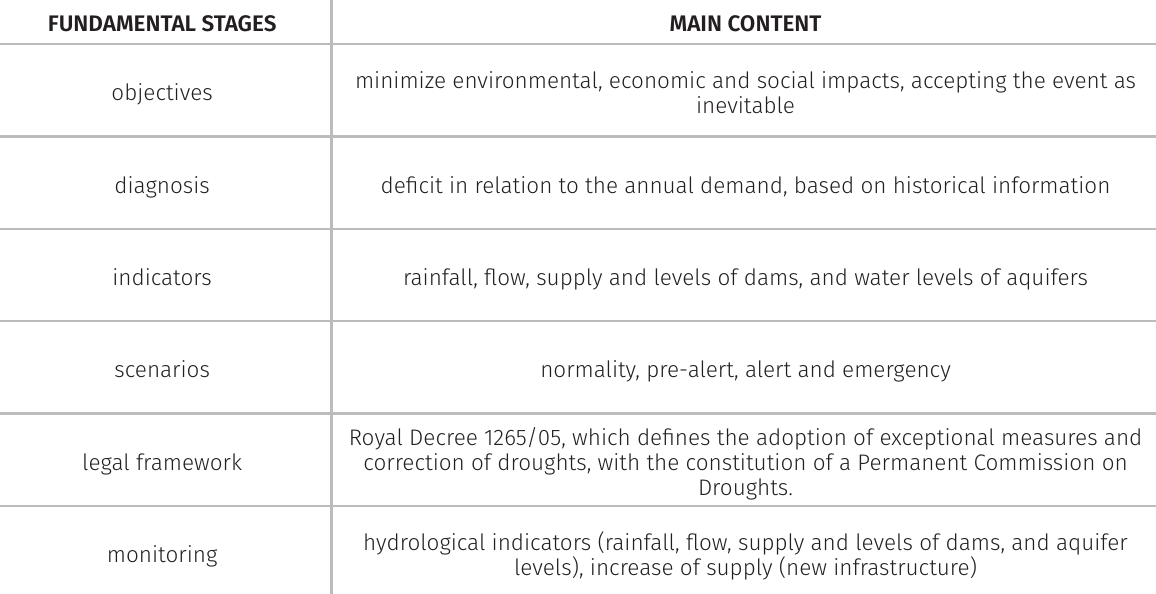
Table II. Summary of the main procedures for the elaboration of the Special Plan for Alert and Eventual Droughts in the Júcar Basin (source: prepared by the